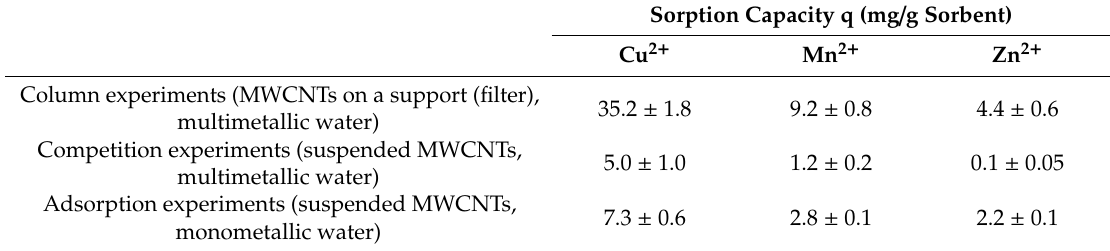
Table 1. Comparison of sorption capacities of oxidized MWCNTs in batch experiments (suspended MWCNTs) and columns